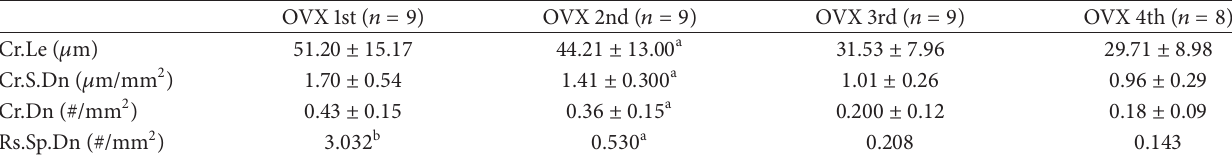
Table 1: Microdamage and absorptive space parameters ( 𝑥 ± 𝑠 ).